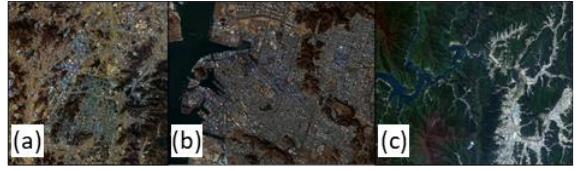
Figure 2. Kompsat-3A images used. (a) Cheonan, (b) Incheon, (c) Yanggu.